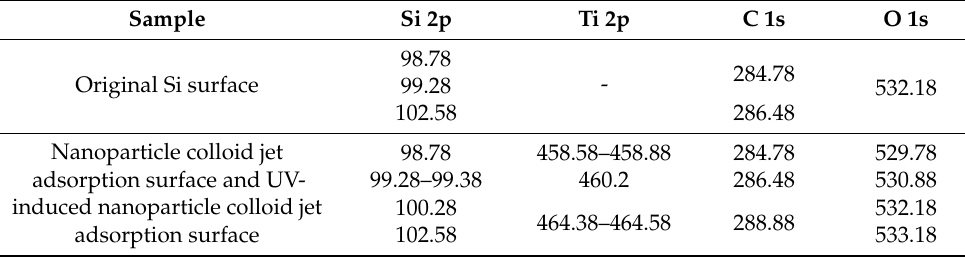
Figure 13. XPS spectra of the UV-induced nanoparticle colloid jet adsorption Si surface: ( a ) Si 2p, ( b ) Ti 2p, ( c ) O 1s, and ( d ) C 1s. Table 3. Position of the Si 2p, Ti 2p, C 1s, and the correspondent O1s (all values are in eV).